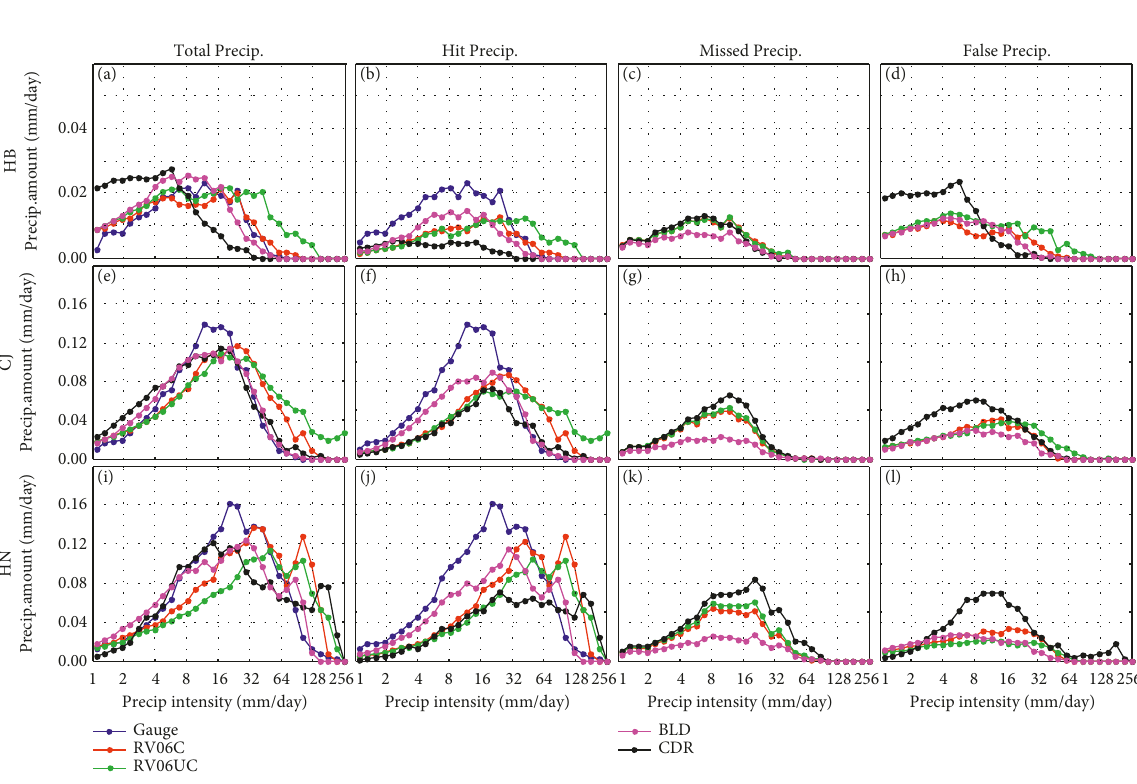
Figure 17: Same as Figure 15 except for the HB, CJ, and HN